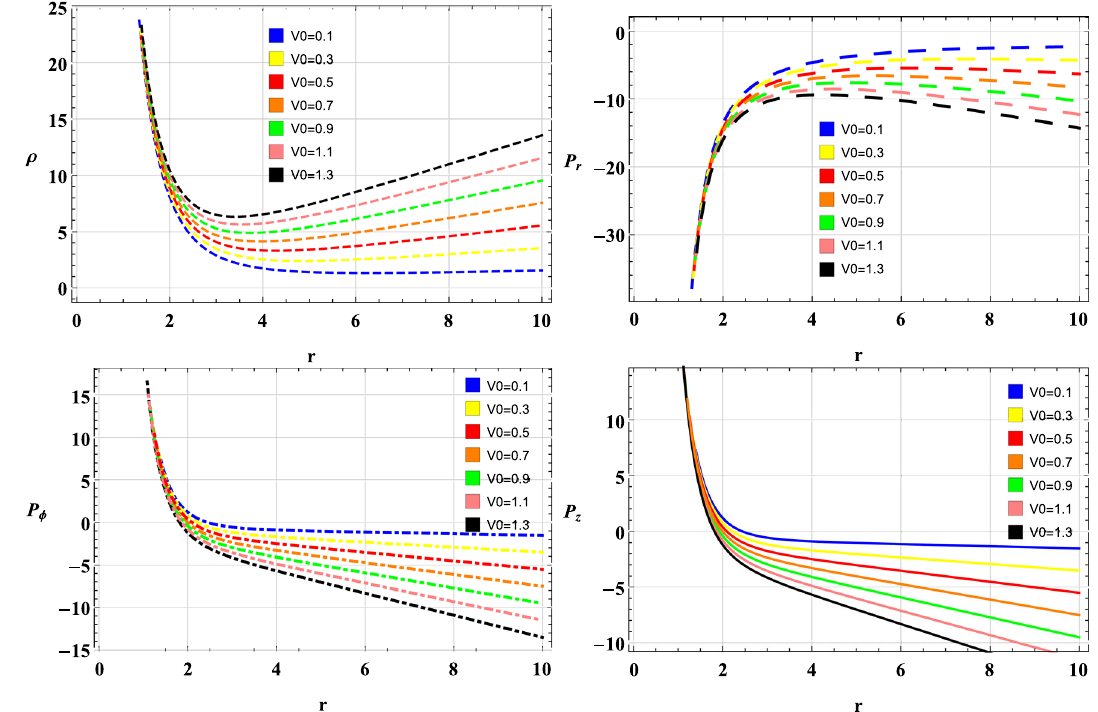
Fig. 17 This panel shows the graphical behavior of energy density (MeV/fm 3 ) , P r (MeV/fm 3 ) , P φ (MeV/fm 3 ) and P z (MeV/fm 3 ) w.r.t r km .